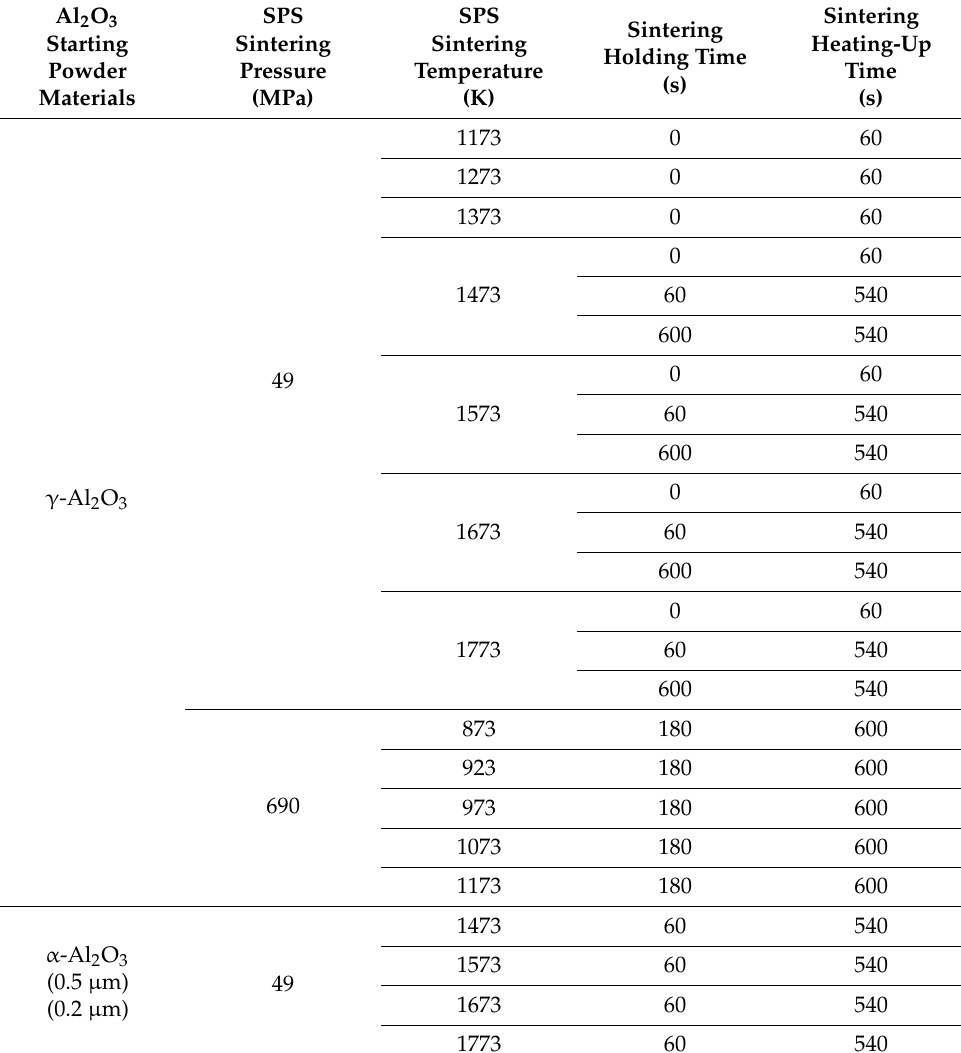
Figure 26. XRD patterns of γ-Al 2 O 3 prepared at 1173–1473 K under 49 MPa. Table 3. SPSs entering conditions of